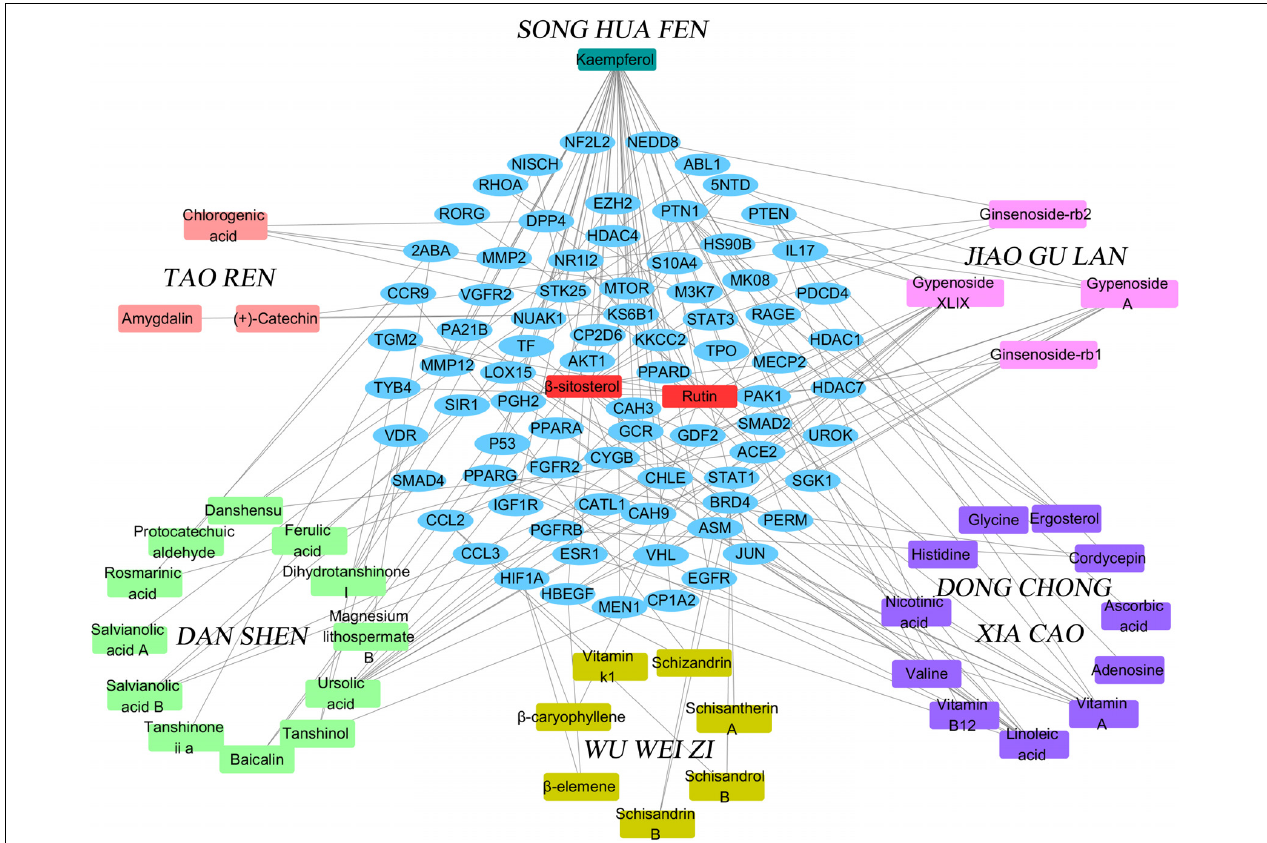
FIGURE 2 | The Component-Target protein network. The rectangles represent the 45 candidate compounds in Fuzheng Huayu (FZHY), the cyan, red, green, yellow, purple, pink rectangles refers to active compounds in Pinus massoniana Lamb. (Song Hua Fen), Prunus persica (L.) Batsch (Tao Ren), Salvia miltiorrhiza Bunge (Dan Shen) , Schisandra chinensis (Turcz.) Baill. (Wu Wei Zi), Cordyceps sinensis (BerK.) Sacc. (Dong Chong Xia Cao), Gynostemma pentaphyllum (Thunb.) Makino (Jiao Gu Lan), respectively. The red rectangles in the center of network represent the common components of several herbs. The blue circles represent the gene names of target proteins of the six herbs found by text mining and molecular